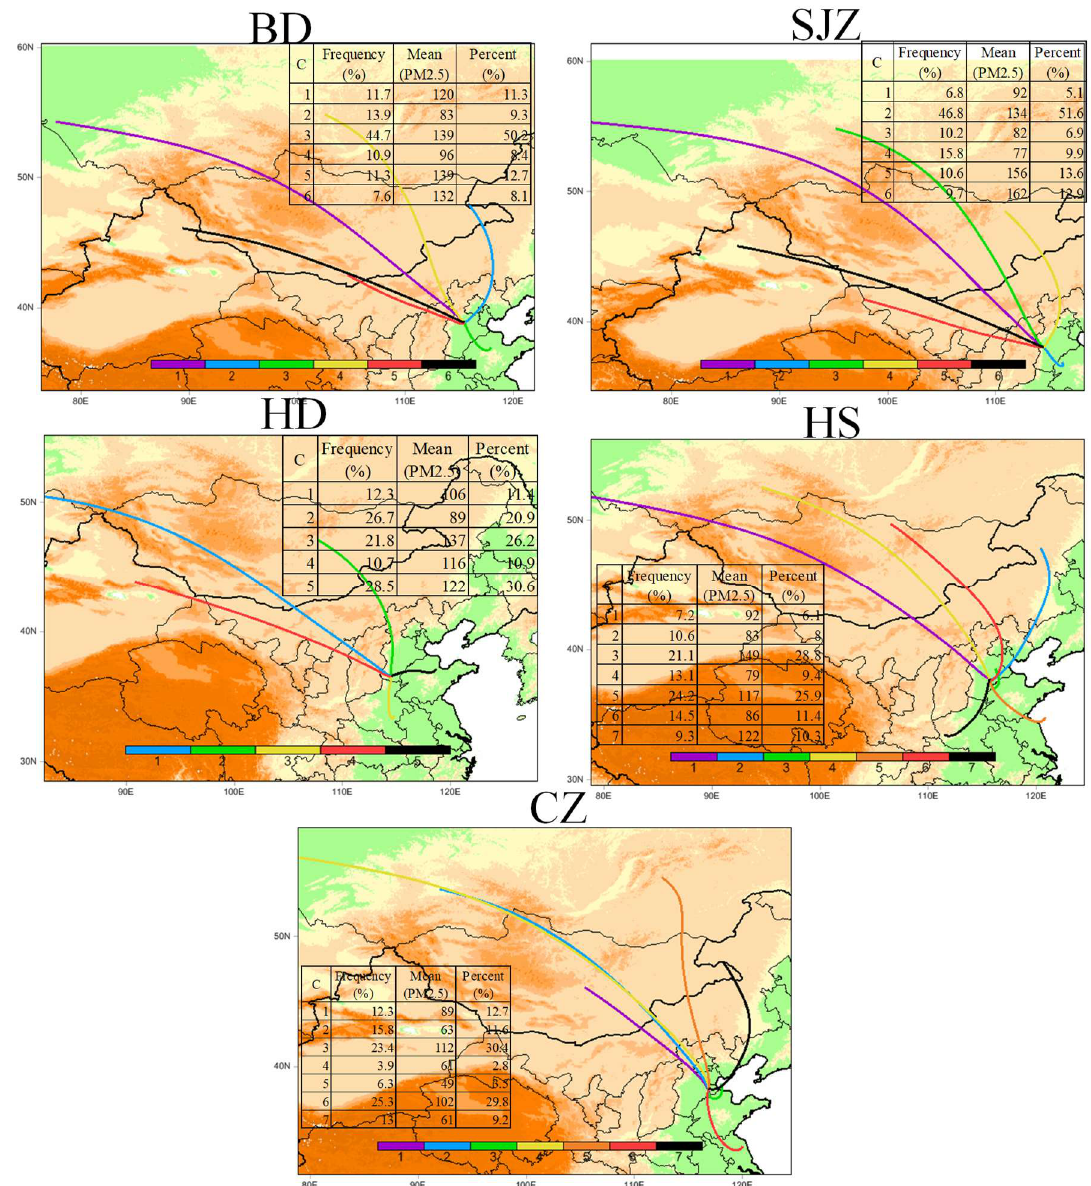
Figure 10. Mean backward trajectory clusters and statistical summary of cluster frequency, PM 2.5 concentrations associated with different trajectory clusters, and normalized contributions for different clusters to PM 2.5 concentrations in five cities during 2013–2015. (C represents Cluster, percent represents the normalized contribution of the cluster frequency and the mean PM 2.5 concentration).